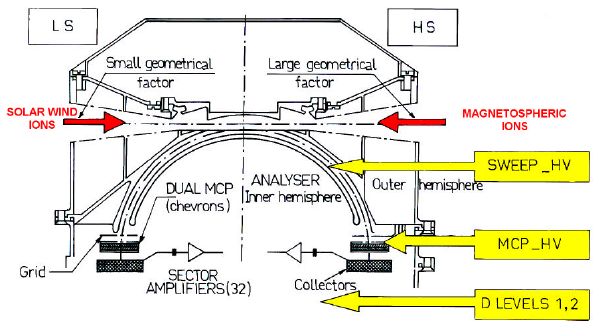
Fig. 2. Cross sectional view of the HIA